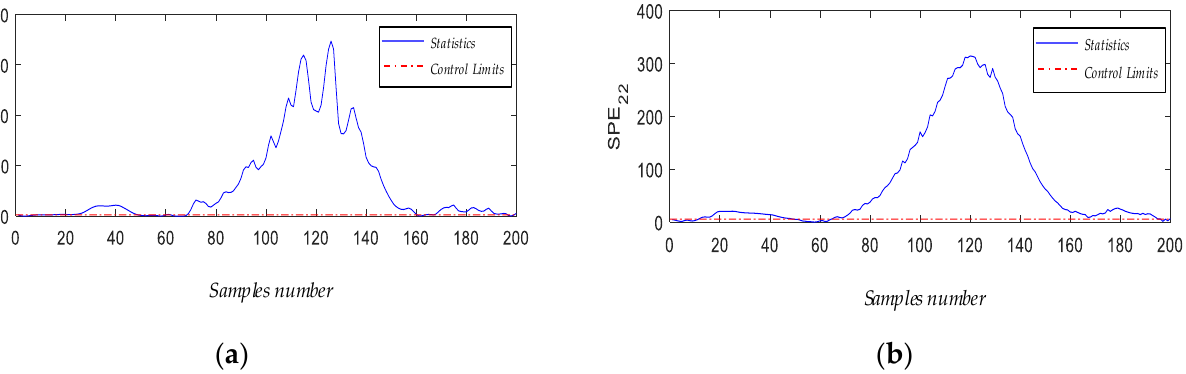
Figure 9. Experimental results of DE-PCA fault detection method for rolling bearing outer ring: ( a ) the result of T 2 ; ( b ) the result of SPE 22 .